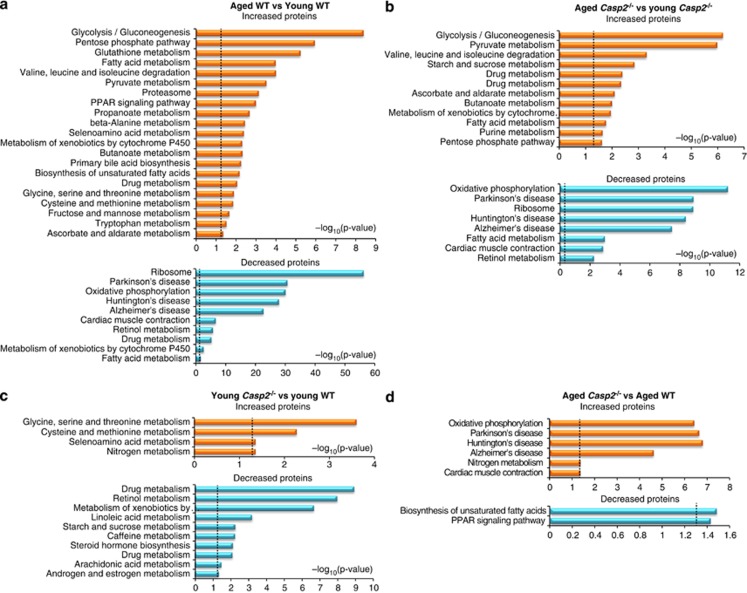
Metabolic and mitochondrial pathways are altered in the liver during ageing of WT and Casp2−/− mice. Pathway enrichment analysis of liver proteins that are differentially abundant during ageing of (a) WT mice, (b) Casp2−/− mice and between genotypes of (c) young and (d) aged Casp2−/− and WT mice. Orange colour represents increased proteins, and blue represents decreased proteins.Vertical lines display cutoff for significance of (−log10(P-value)) with Benjamini's correction. Enrichment of Kyoto Encyclopedia of Genes and Genomes (KEGG) pathway was performed using DAVID Bioinformatics resources 6.7 (http://david.abcc.ncifcrf.gov). Details of individual proteins included in each enriched biochemical pahtway can be found in Supplementary Table S5. See Supplementary Figure S3